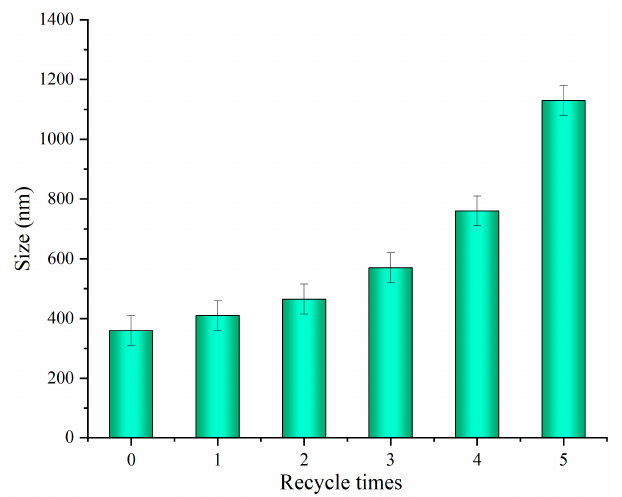
Figure 9. Length of the CNCs after each reuse cycle.